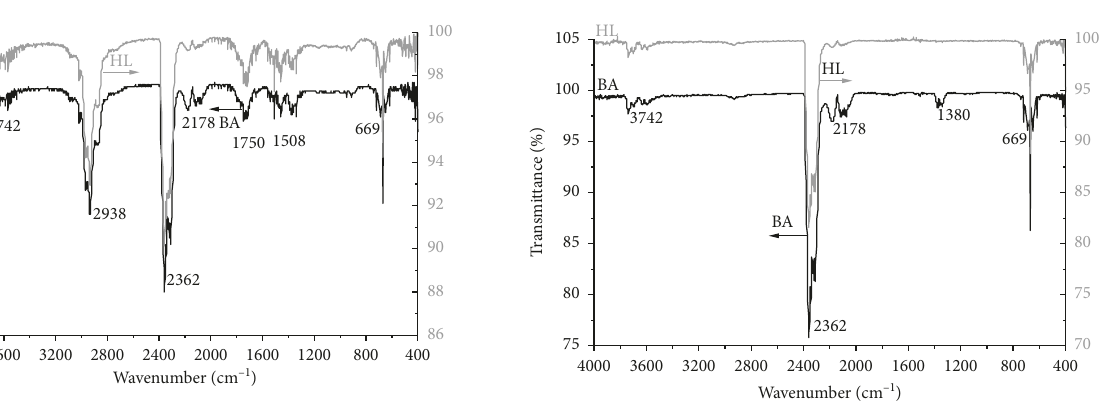
Figure 6: Infrared spectra of gaseous volatiles in the second combustion stage of BA and